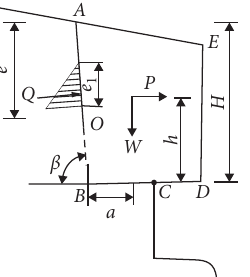
Figure 14: Calculation model for the unstable tipping-type rock.